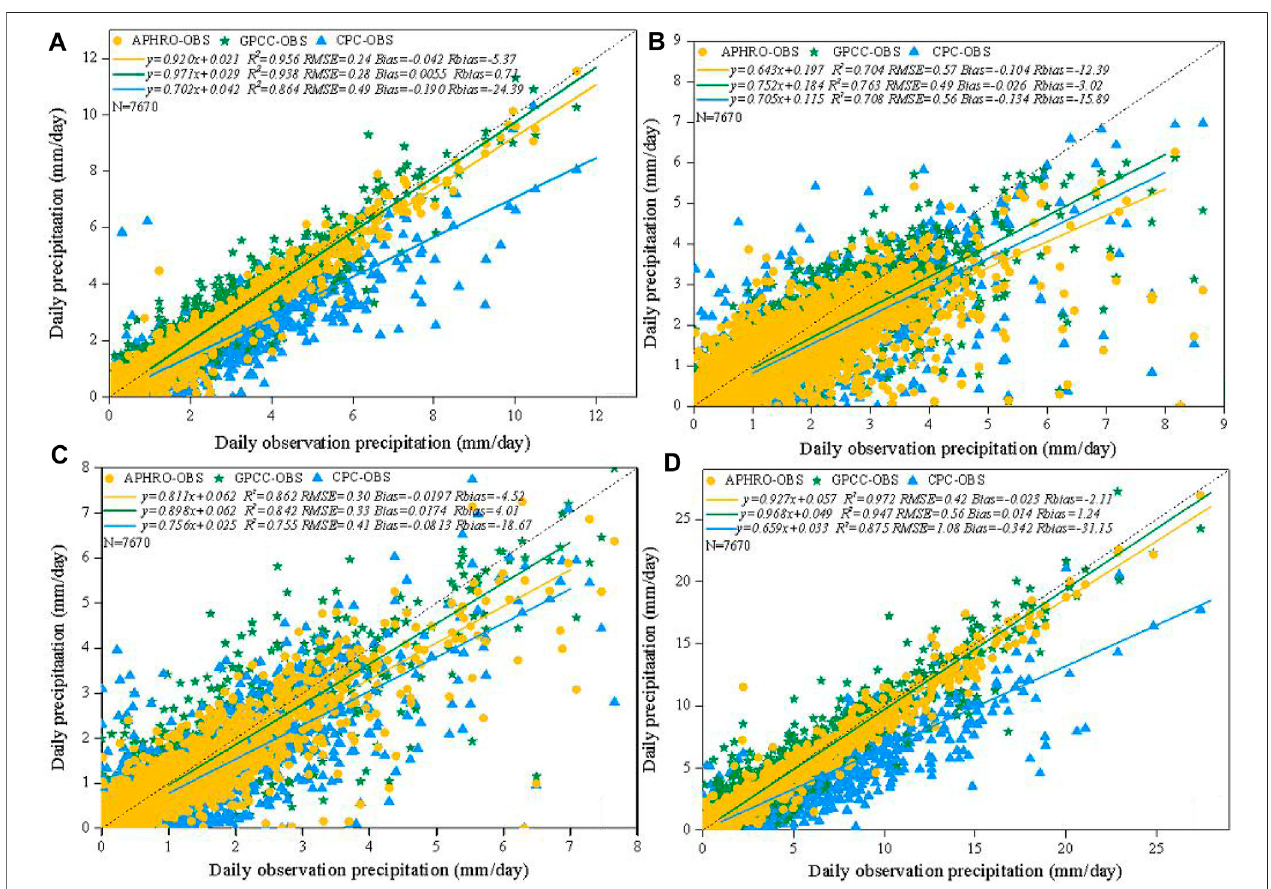
FIGURE 4 | Scatter plots of OBS daily precipitation versus APHRODITE (yellow circle), GPCC (green pentagon), CPC(blue triangle) over CA (A) and sub-regions (B – D) from January 11,985 to December 31, 2005. (B) represent in the NCA; (C) represent in the SWCA; (D) represent in the SECA.The black dotted lines are the 1:1 line, and the yellow, green, and blue solid lines represents the linear regression fi tting lines for APHRODITE, GPCC, and CPC, respectively.